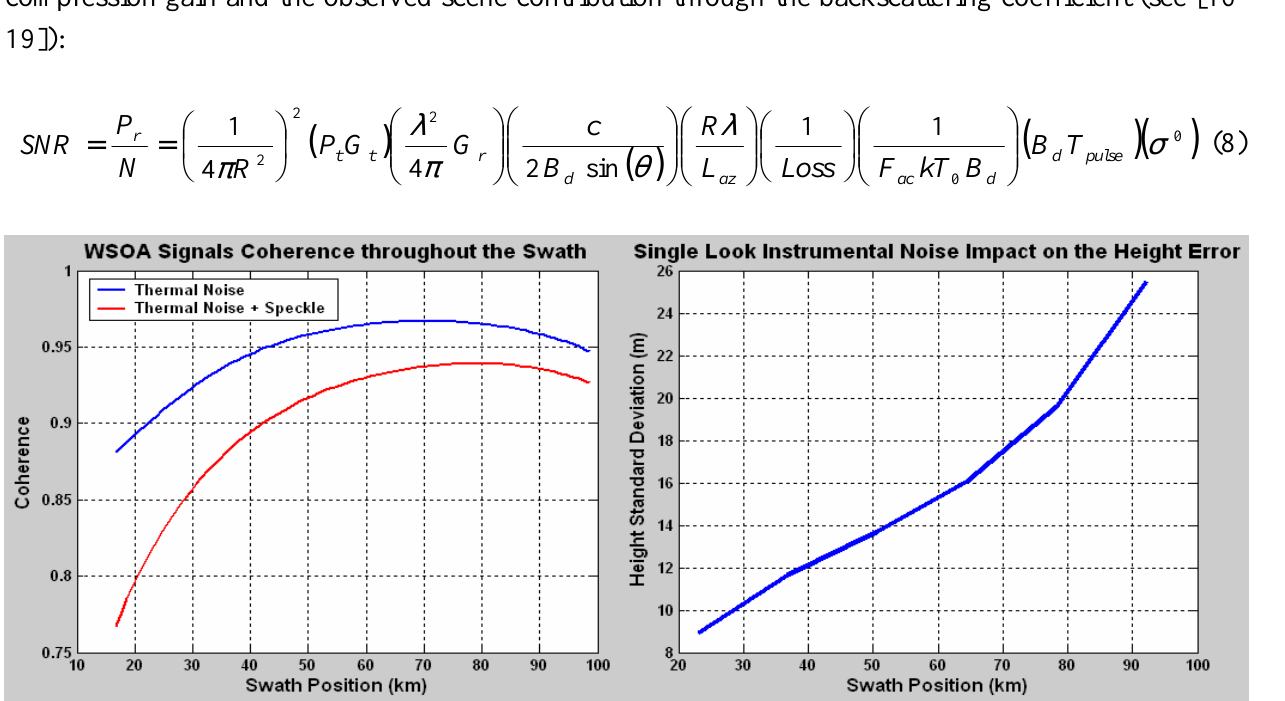
Figure 5. (a) WSOA signal coherence throughout the swath with and without the onboard correction of the geometric decorrelation (b) Single looking instrumental noise impact on the height